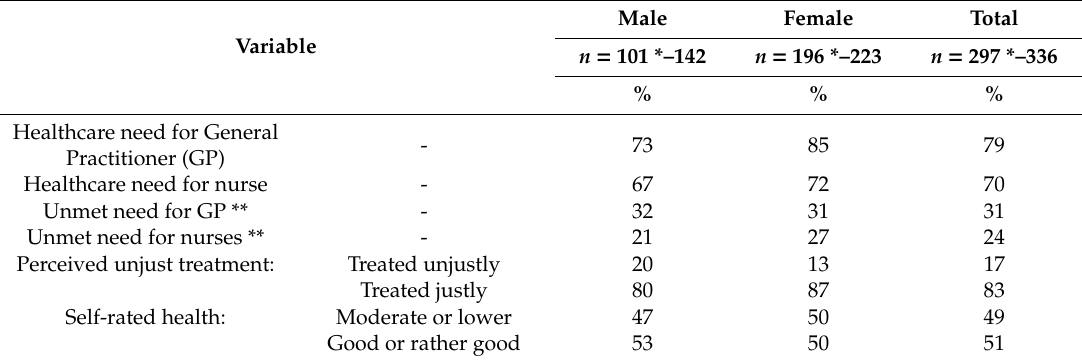
Table 2. The prevalence of the primary care need, of the unmet need, and of the perceived unjust treatment and the self-rated health, %, n